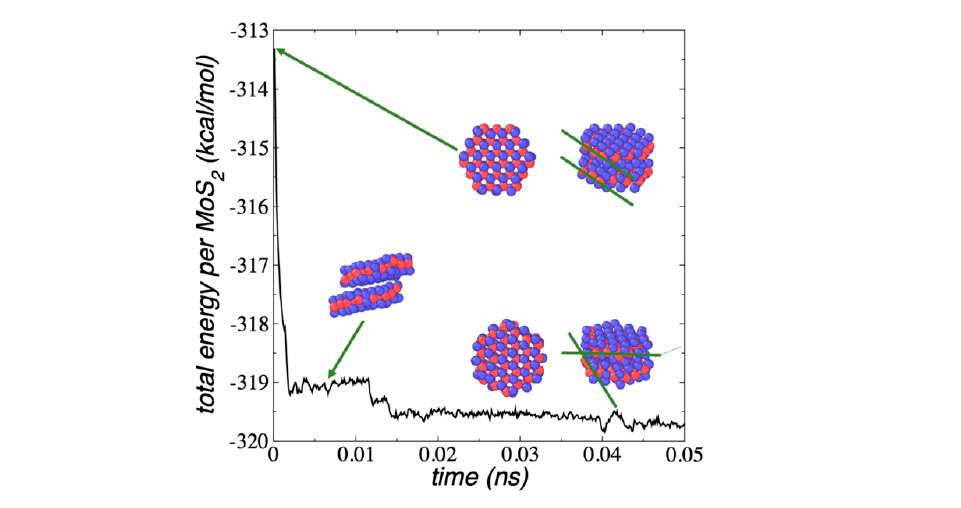
Figure 6. E #MoS2 of the Mo 27 S 54 , 2L flake as a function of simulation time, under vacuum and NVT conditions at 298.15 K. The inset snapshots correspond to the initial (same orientation), intermediate (slid) and equilibrated (shifted orientation, 60°) conformations of the flakes. Blue and red spheres represent Mo and S atoms, respectively.